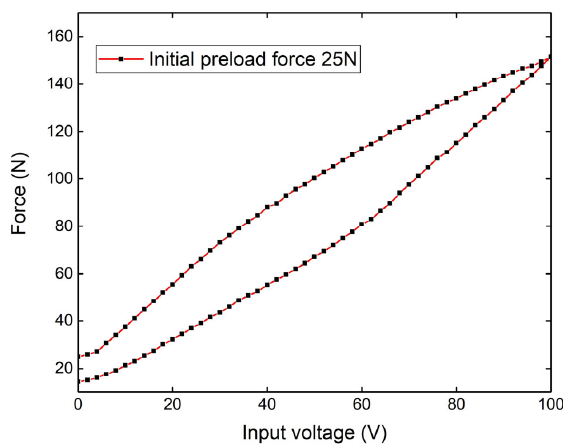
Figure 4. The curve of measured hysteresis loop.